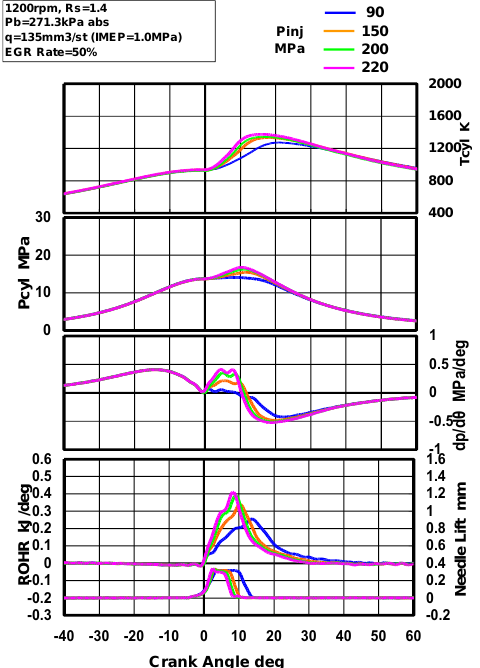
Fig. 15. ROHR by Changing Pinj at EGR rate